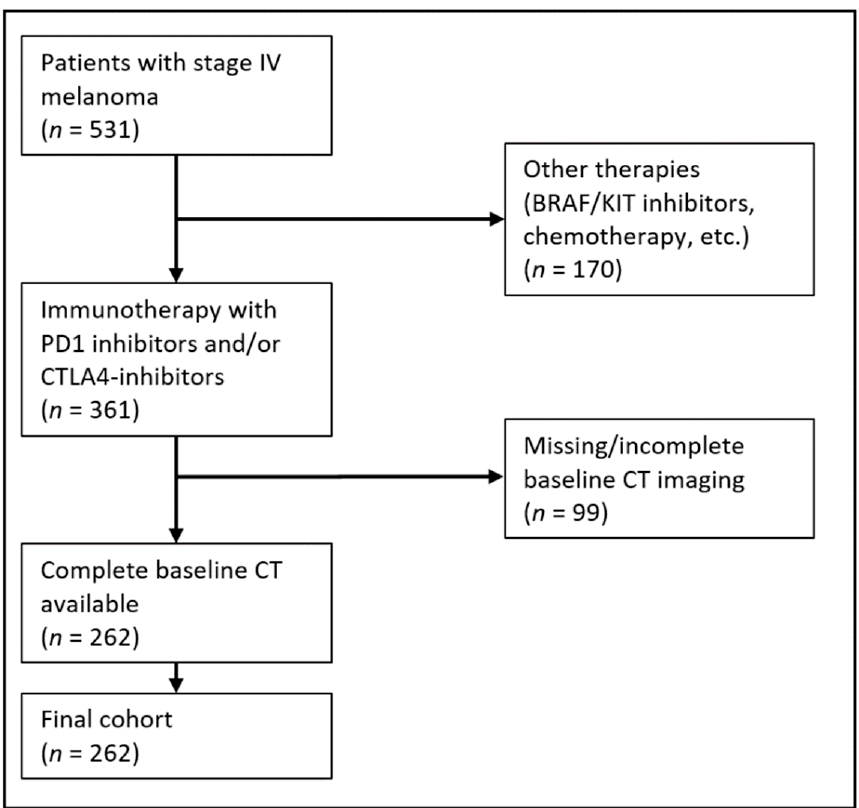
Figure 2. Patient